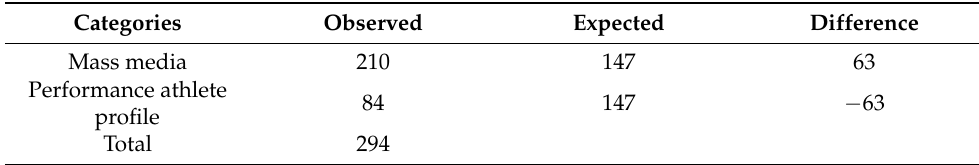
Table 8. Observed frequencies and expected frequencies obtained for the variables “mass media” and “performance athlete profile.”